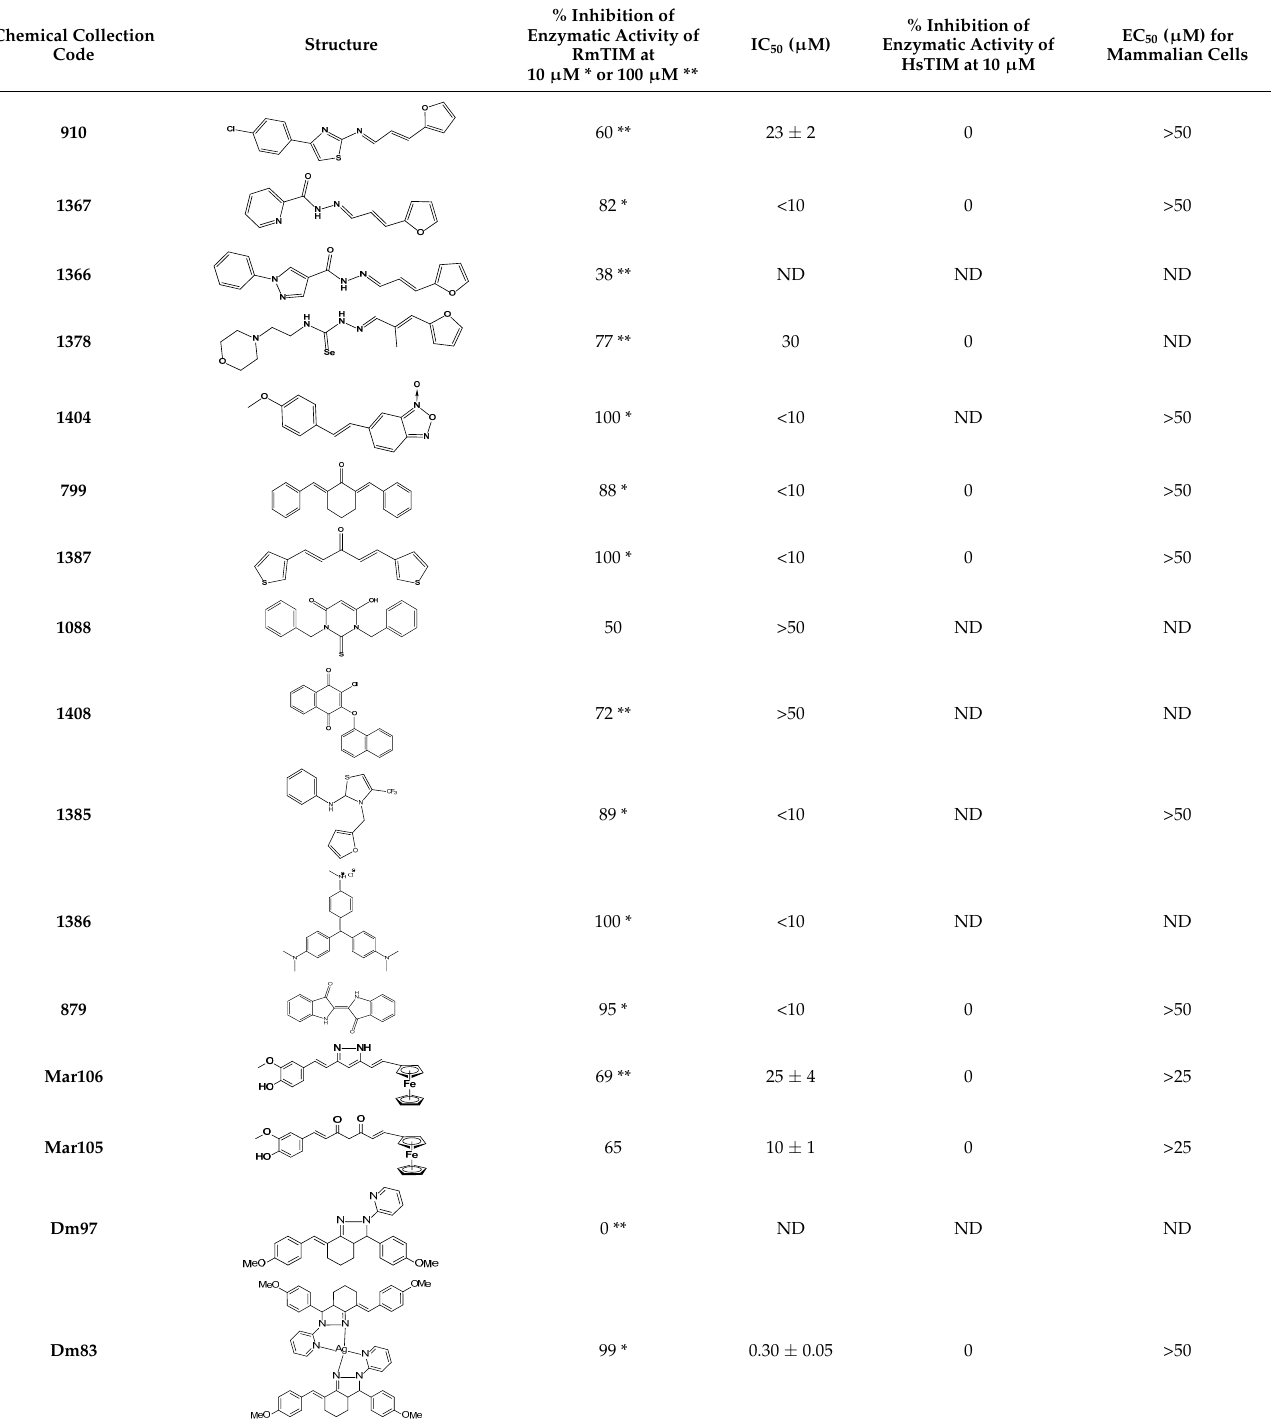
Table 4. Toxicity effect of extracts (1 mg/mL) and compounds in the LIT (1.0 mM) and the AIT (1.5 mM).